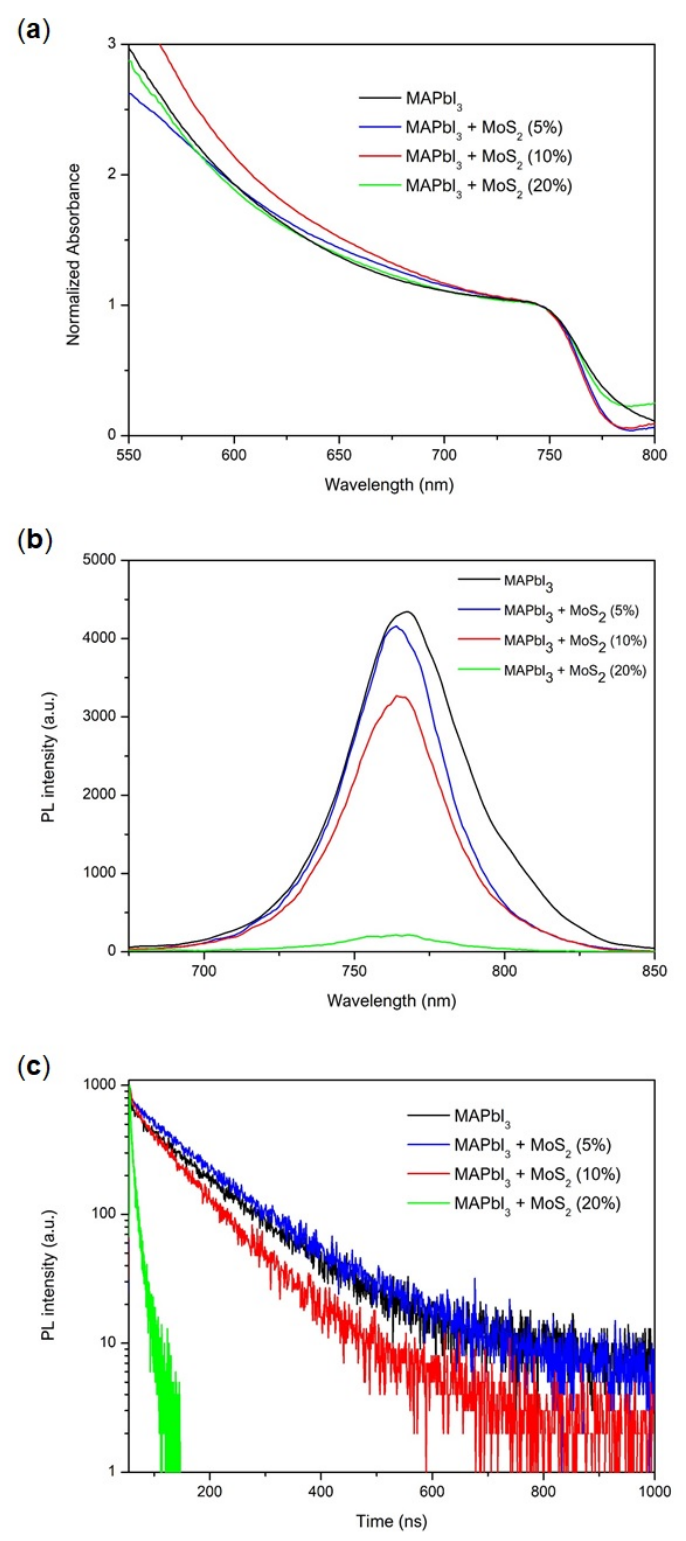
Figure 7. ( a ) UV-Vis, ( b ) steady-state photoluminescence (PL) and ( c ) time-resolved photolumines- cence (TRPL) spectra of the MAPbI 3 perovskite films, with and without MoS 2